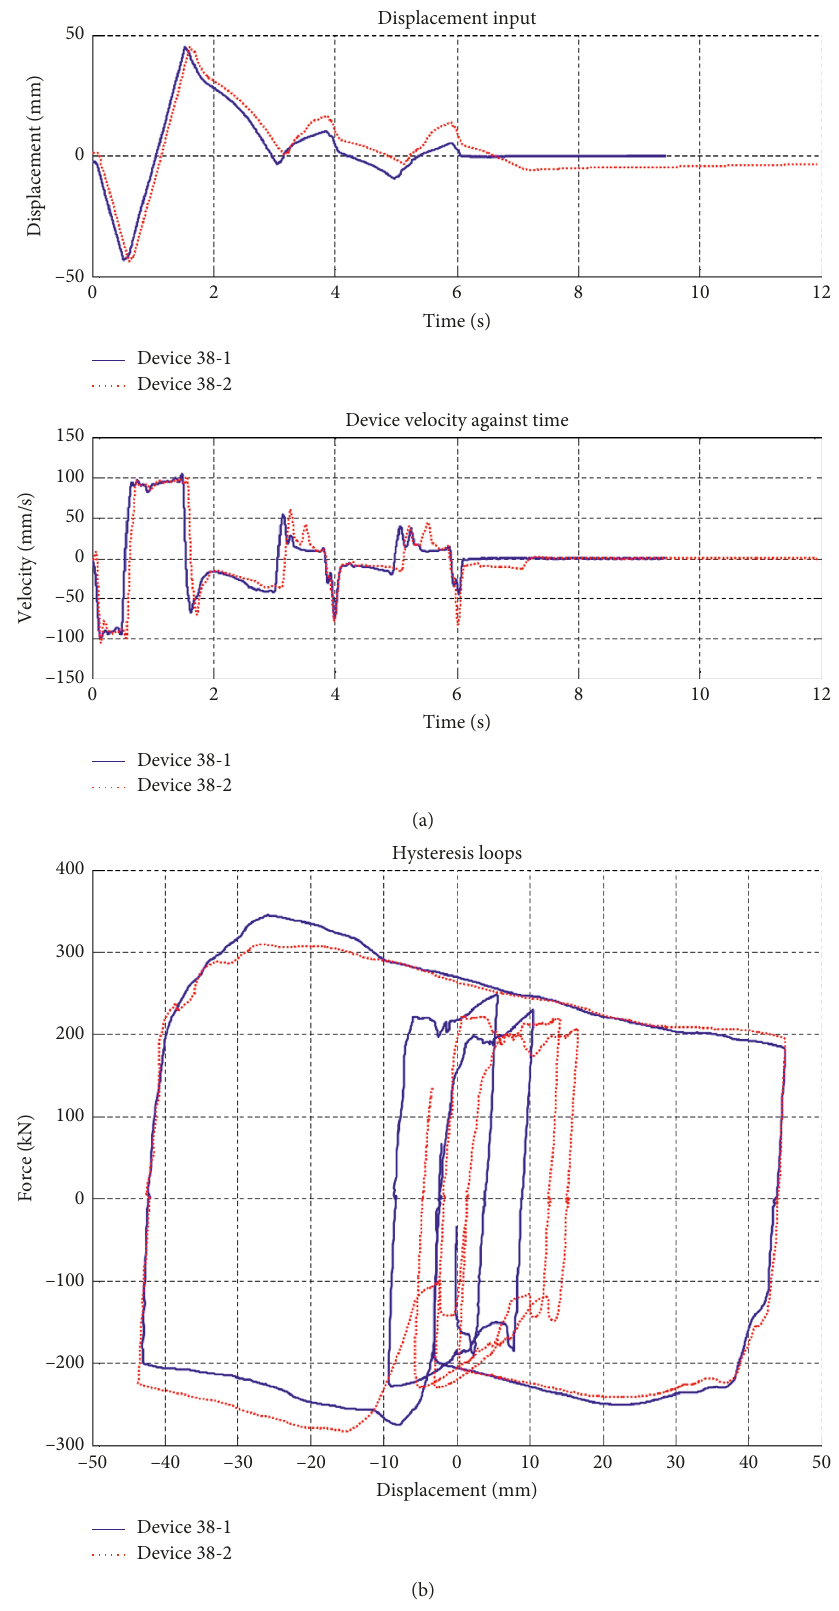
Figure 7: Representative results showing 3 fully reversed cycles at 100.0mm/s device velocity command (but not achieved) with inputs of displacement and velocity (a) and resulting hysteresis loops